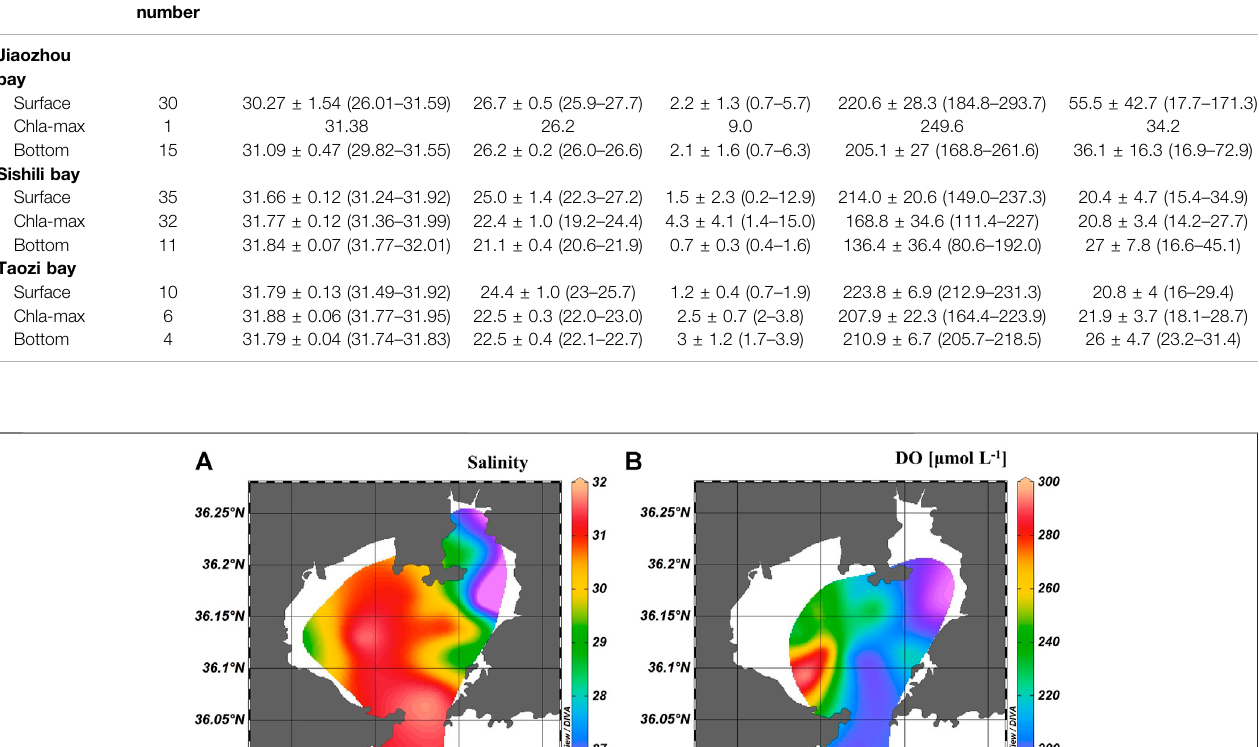
TABLE 1 | Summary of physicochemical parameters in Jiaozhou Bay, Sishili Bay, and Taozi Bay (Mean ± SD (Min-Max). Bay